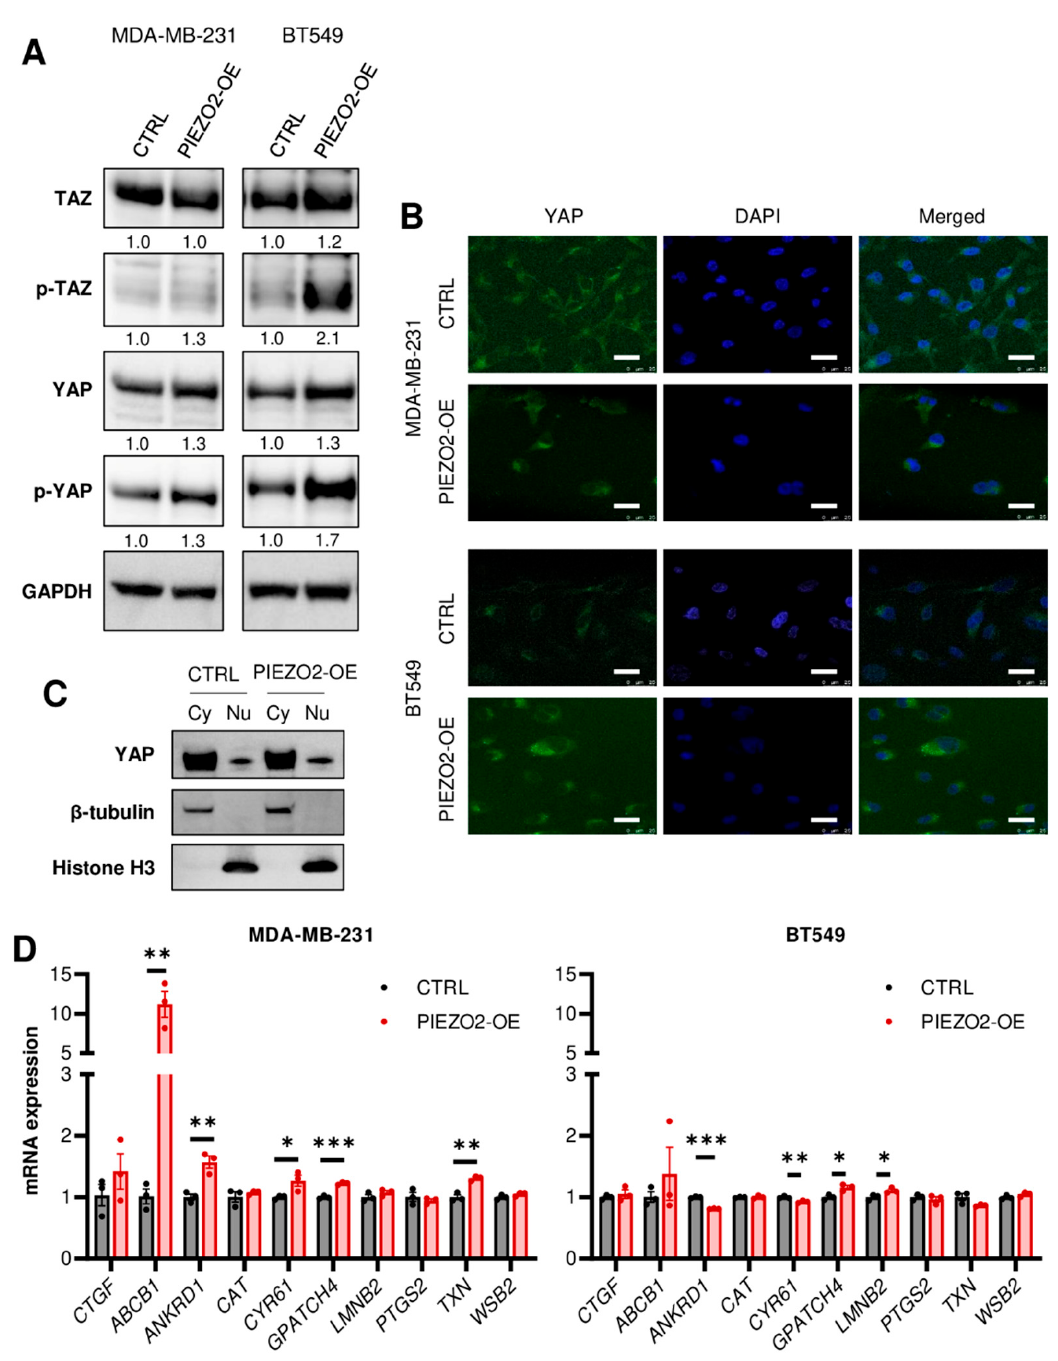
Figure 4. Overexpression of PIEZO2 has no significant impact on YAP/TAZ signaling pathway. ( A ) Western blotting of TAZ, p-TAZ, YAP, p-YAP, and GAPDH in control (CTRL) and PIEZO2 overex- pressed (PIEZO2-OE) MDA-MB-231 and BT549 cells. ( B ) Representative immunofluorescent images of YAP with nuclear DAPI staining in control and PIEZO2 overexpressed cells in MDA-MB-231 and BT549. Scale bar indicates 25 µm. ( C ) Western blot of YAP, β -tubulin, Histon H3 in the cytosol (Cy), and nuclear (Nu) fraction of MDA-MB-231 control and PIEZO2 overexpressed cells. ( D ) YAP/TAZ target genes expressions in control and PIEZO2 overexpressed cells in MDA-MB-231 and BT549. * p < 0.05, ** p < 0.01, and *** p < 0.001.